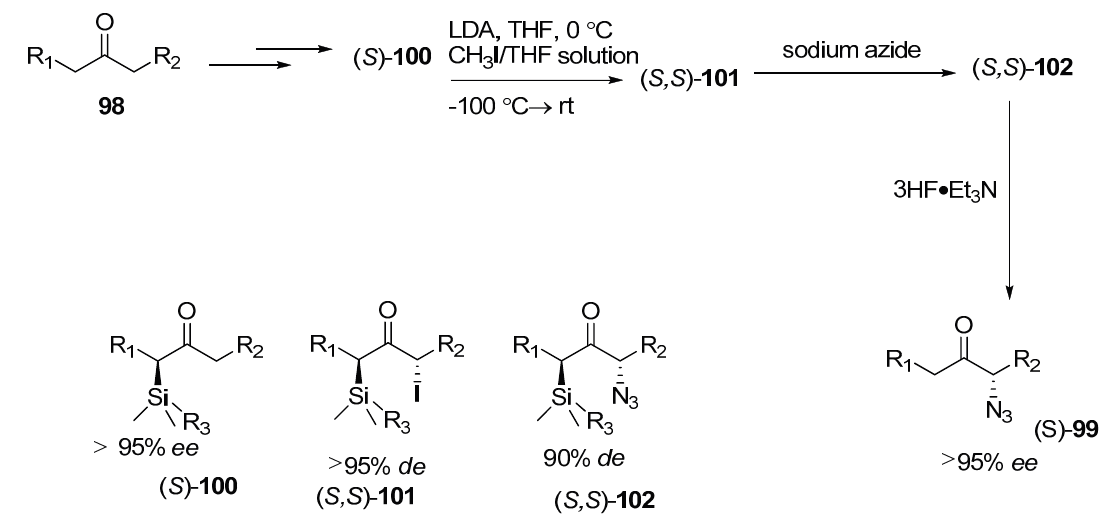
Scheme 42. Enantioselective synthesis of α -azido